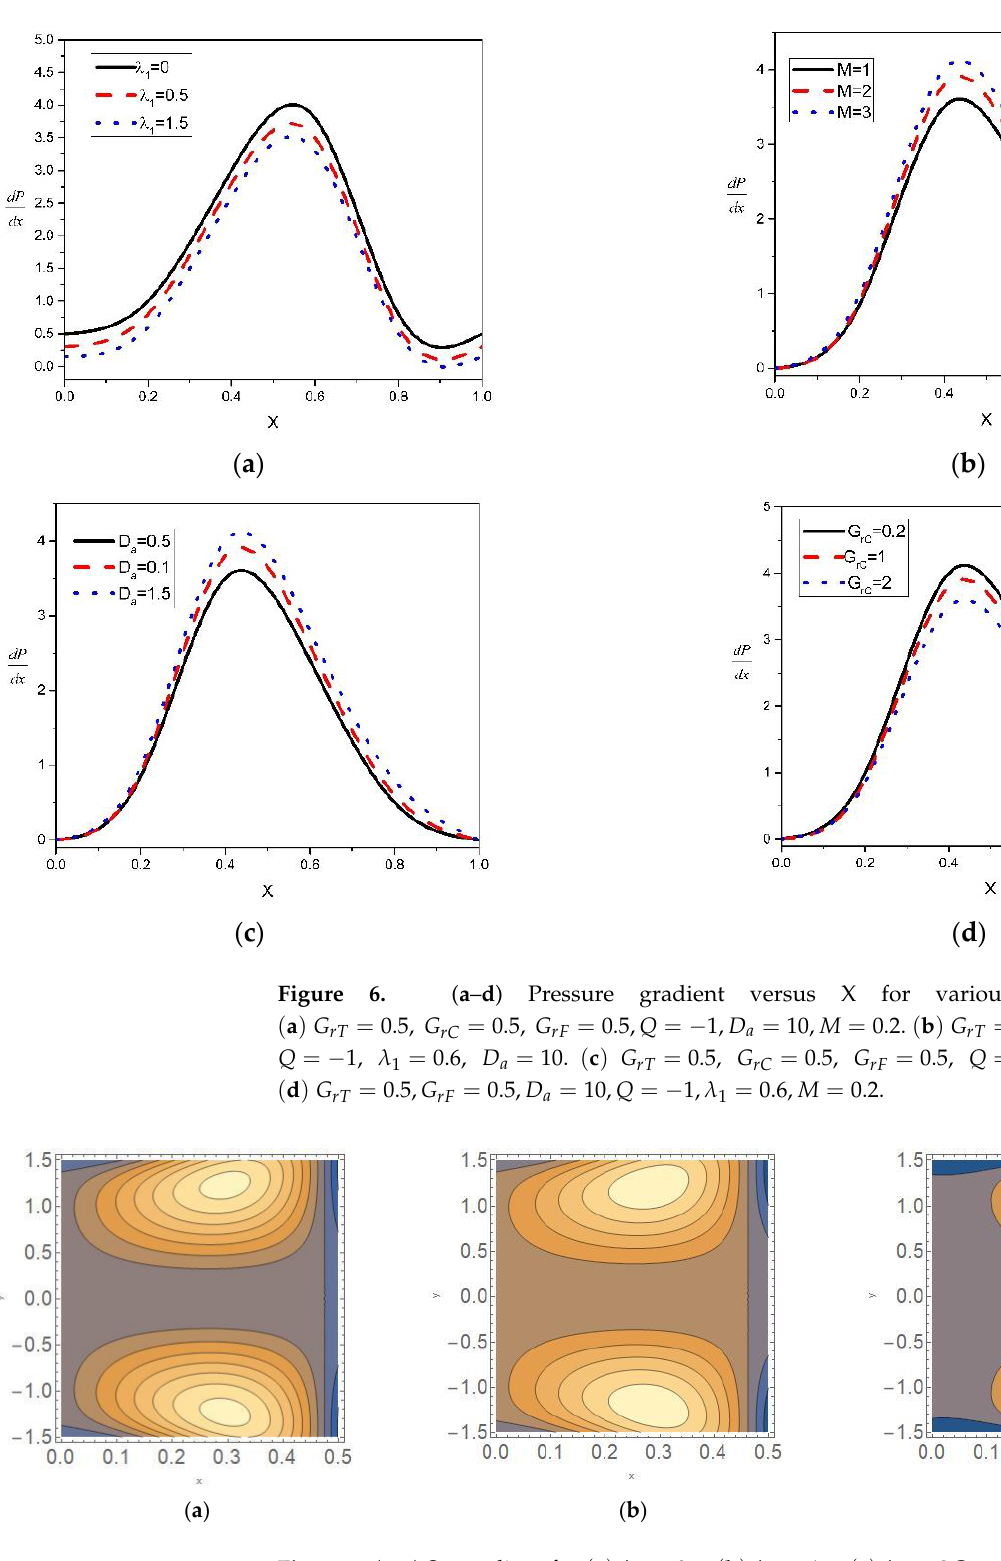
Figure 7. ( a – c ) Streamlines for ( a ) λ 1 = 0, ( b ) λ 1 = 1, ( c ) λ 1 = 2 G rT = 0.5, G rC = 0.5, G rF = 0.5,